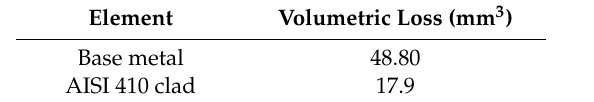
Table 6. Volumetric loss using Archard equation at sliding time of 478 s.